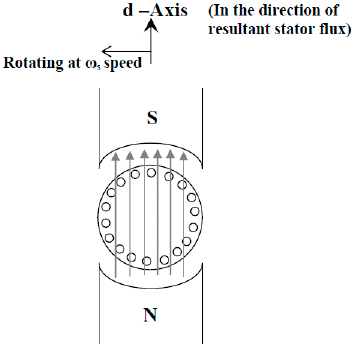
Figure 2. Illustration of stator d-Axis for a DFIG.